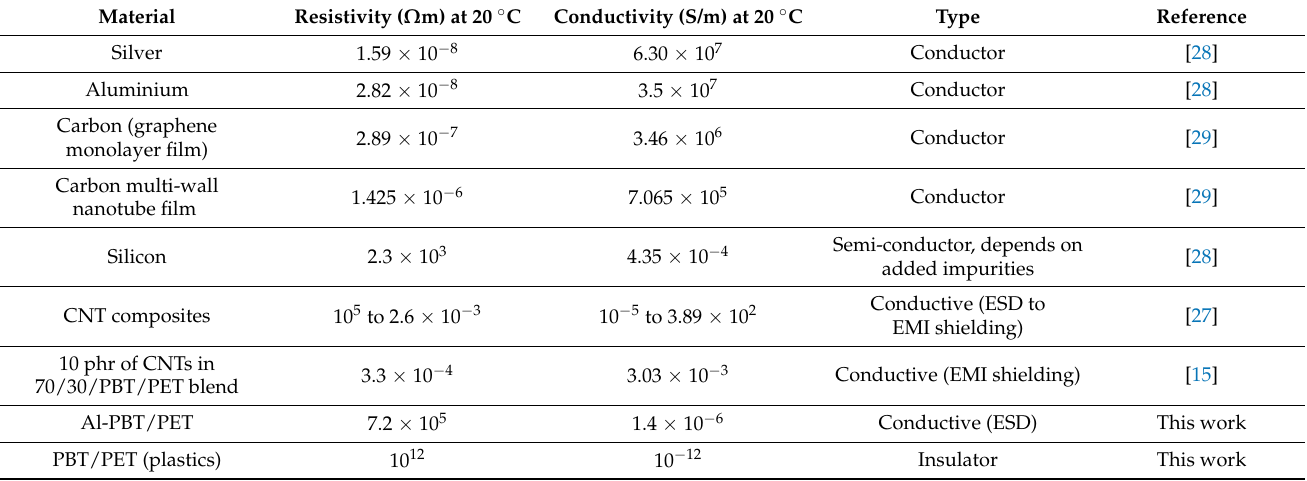
Table 3. Resistivity and conductivity at 20 ◦ C of a range of materials.